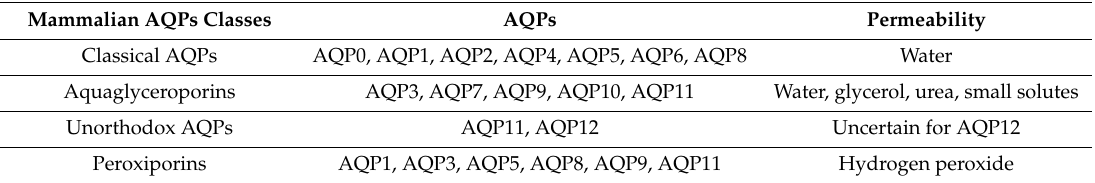
Table 1. Mammalian aquaporin (AQP)